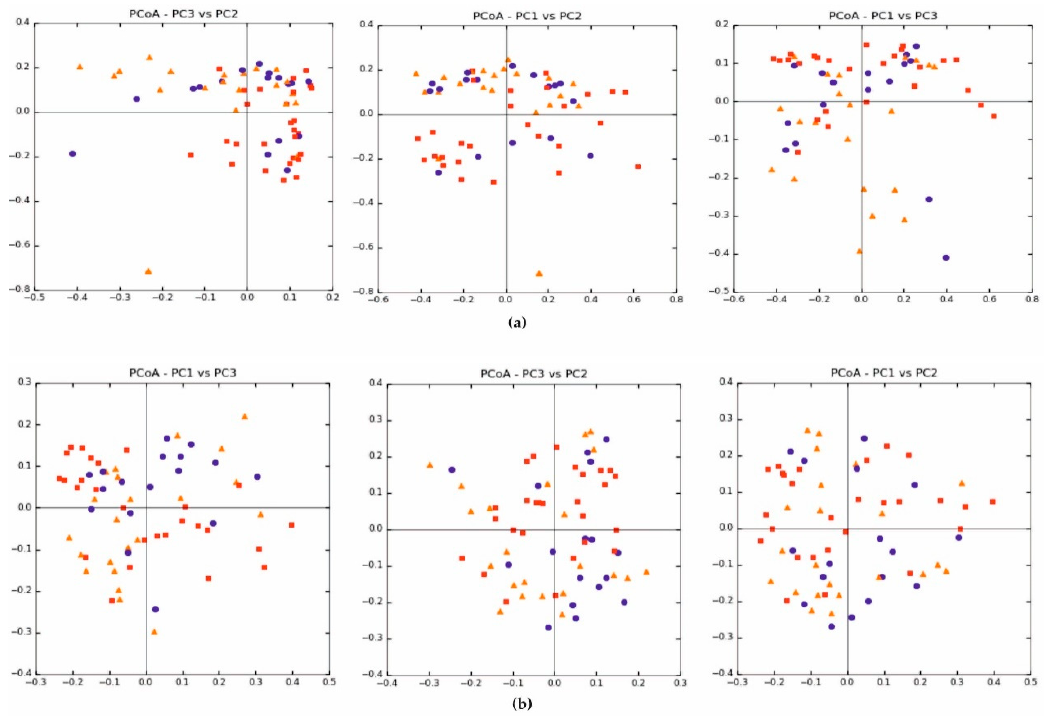
Figure 2. Beta diversity expressed in: ( a ) weighted UniFrac and ( b ) unweighted